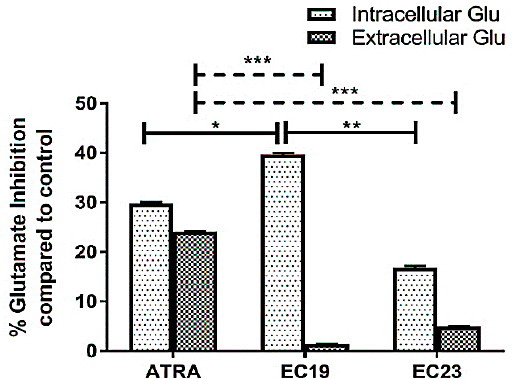
Figure 6. The percentages of both intracellular and extracellular glutamate inhibition. The reduction in glutamate levels was calculated after the manipulation of Caco-2 cells with IC 50 doses of ATRA and each EC-synthetic analogue. Data are presented as mean ± SEM of three-independent experiments. Significant inhibition of intracellular glutamate with EC19-treated cells was observed compared to ATRA and EC23 treatments. Also, significant inhibition in extracellular secreted glutamate was observed with ATRA compared to both EC19 and EC23. The significance in p -values for comparisons is indicated as * p < 0.05, ** p < 0.01 and *** p < 0.001.